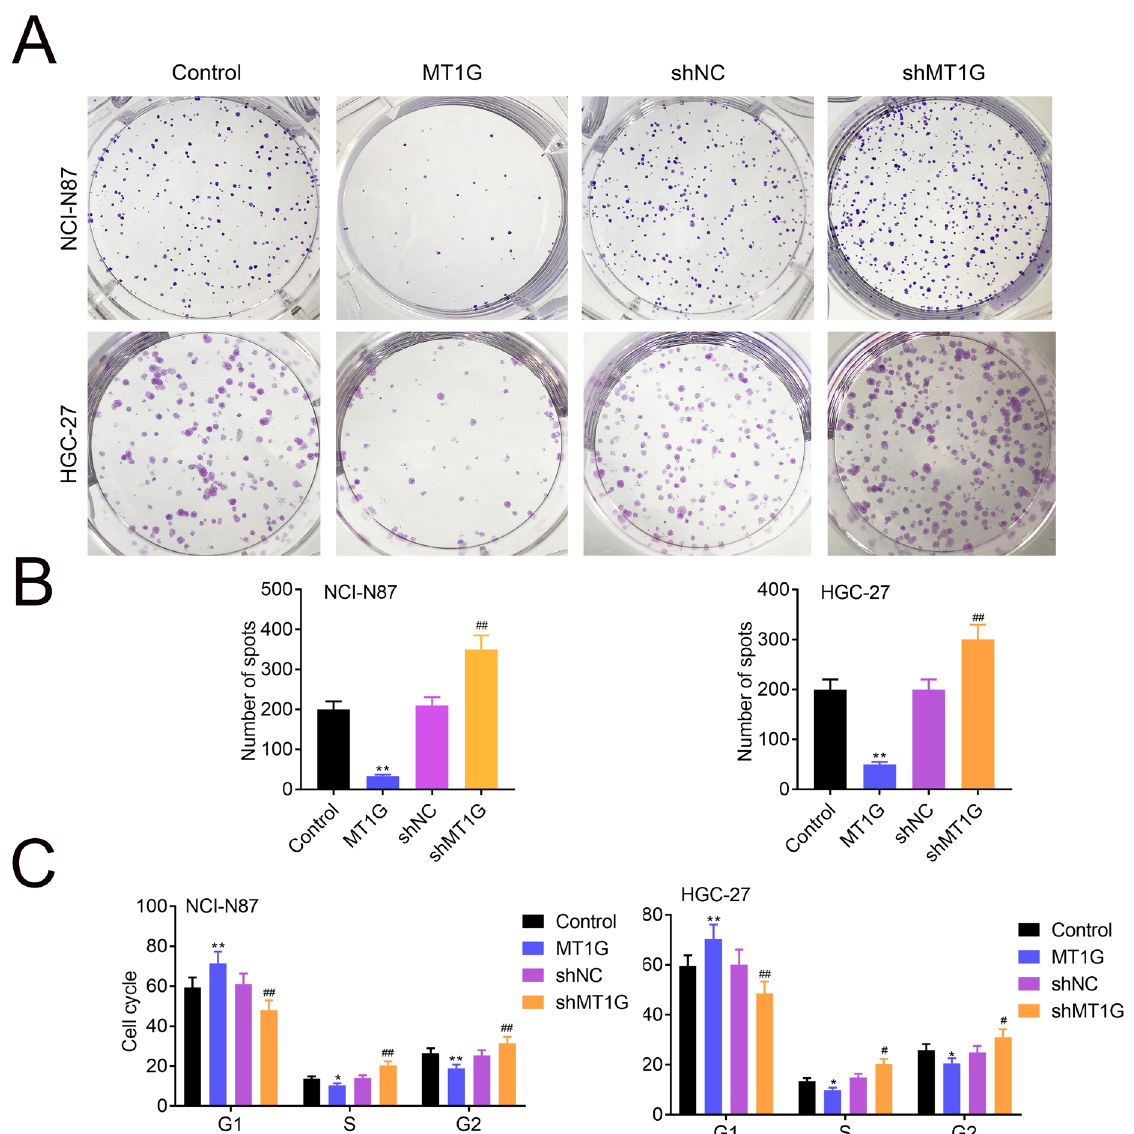
Figure 3 – MT1G inhibits cell cycle progression of GC cells. (A and B) Clonogenic assay was performed to measure the capacity of foci formation in knockdown or overexpression of MT1G NCI-N87 and HGC-27 cells. (C) The effects of MT1G overexpression, knockdown on cell-cycle progression in NCI-N87 and HGC-27 cells were determined by propidium iodide staining and flow cytometry analysis. Error bars represent data from three independent experiments (mean±SD). * P<0.05, ** P<0.01, #P<0.05, ##